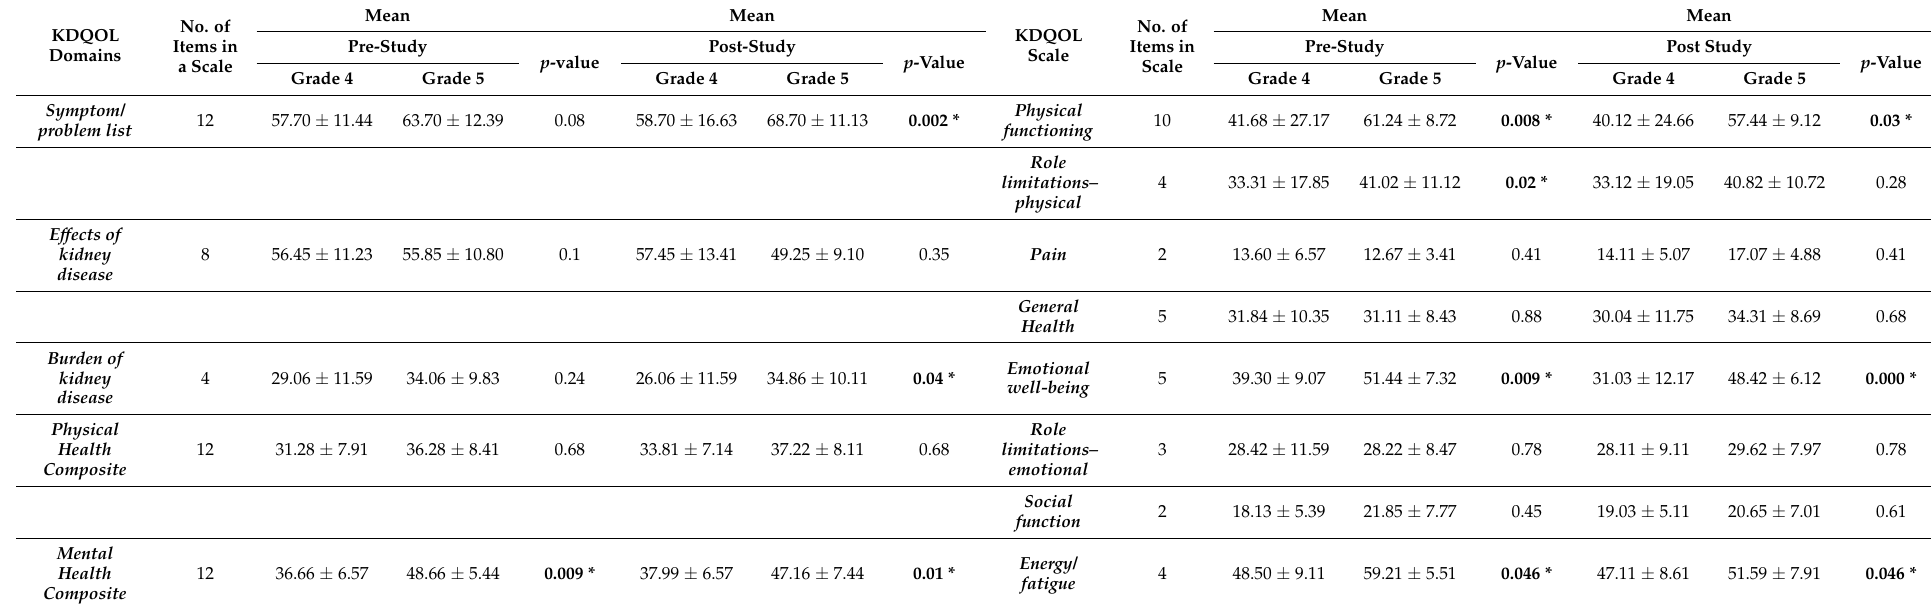
Table 3. Pre and Post mean assessment score of KDQOL-SF-36 Domain and Scale